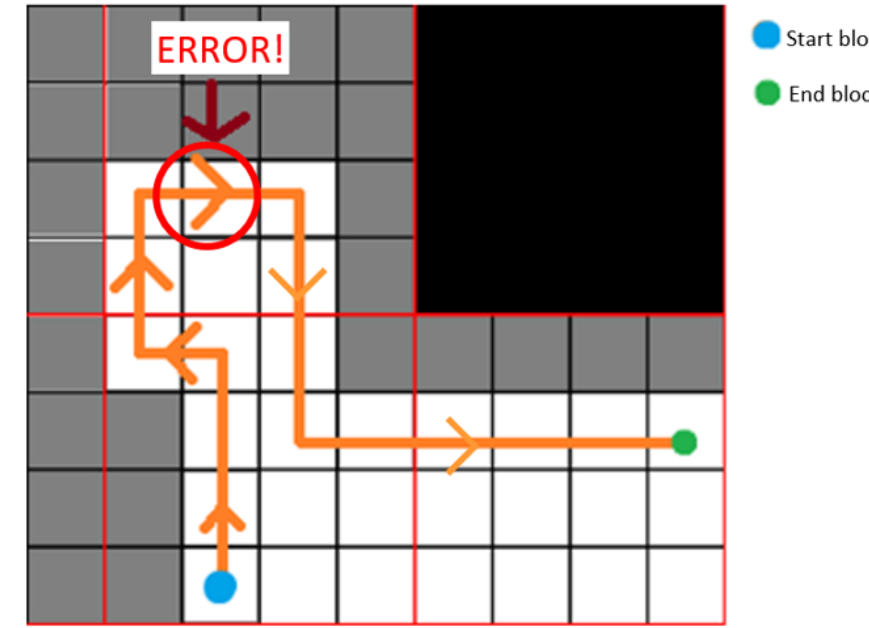
Figure 16. Tracing the direction of the path (bubble rule).